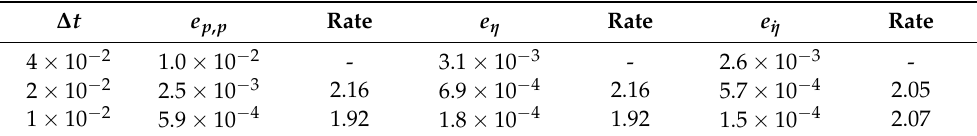
Table 4. Temporal convergence test for variables p p , η and ˙ η